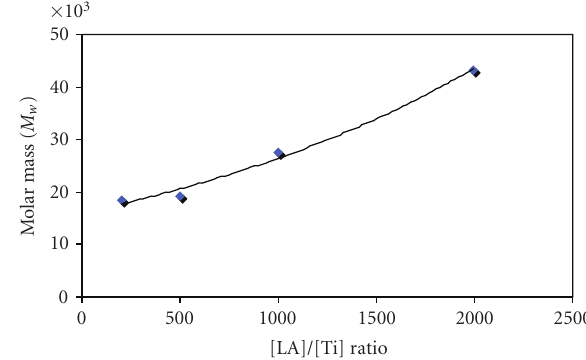
Figure 2: Variation of the molecular weight ( M w ) of PLDA as a function of the monomer/catalyst